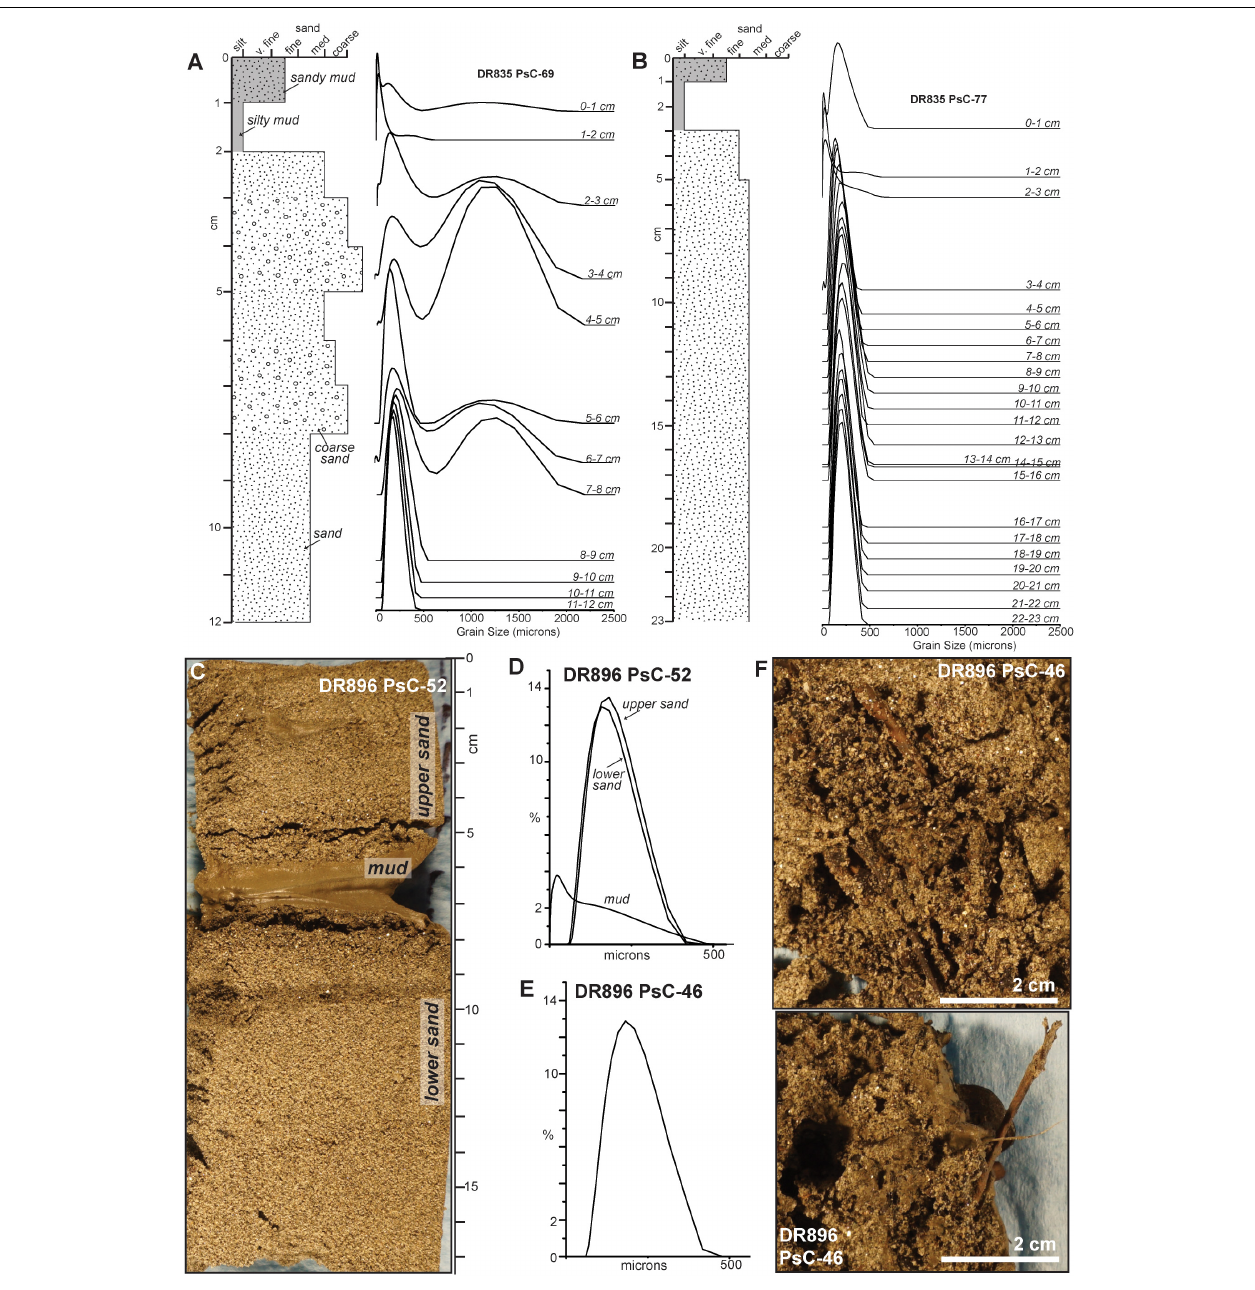
FIGURE 8 | Remotely operated vehicle (ROV) pushcore samples acquired near MS7. (A,B) Pushcores acquired in April 2016, following the January 15, 2016 event, shown as schematic log ( left ) and grain-size distributions ( right ). Stratigraphy and coarse grain size populations differ between these two closely spaced pushcores (57 m apart). See Figure 1B for sample locations. (C–F) Pushcores acquired in October 2016, after the September 1, 2016 event, shown as photographs and grain-size distributions. Woody plant material in sand is highlighted in (F) . See Figure 1C for sample